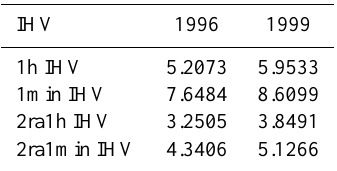
Table 3. Annual IHV-raw values for ESK observatory in 1996 and 1999 using four differently treated data